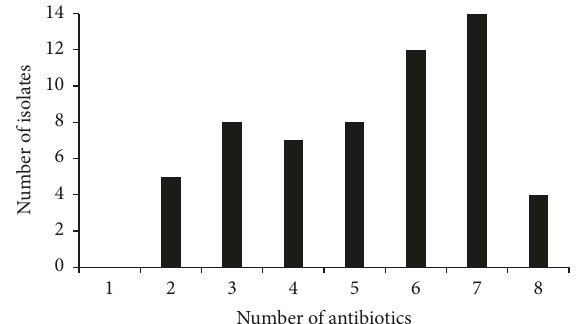
Figure 1: Frequency of resistant bacterial isolates to the eight antibiotics